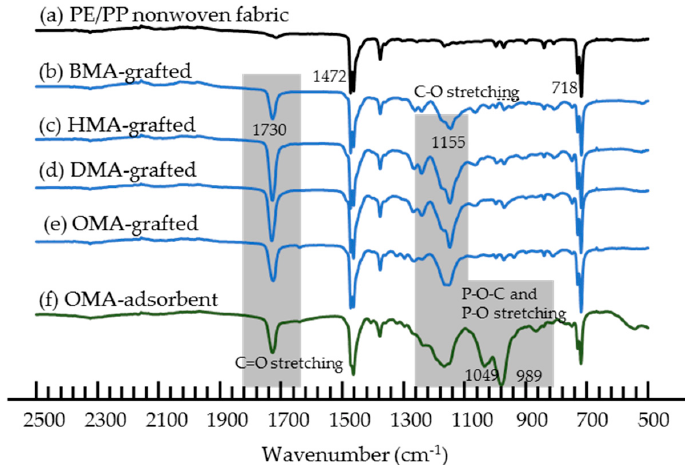
Figure 2. FTIR spectra of ( a ) PE / PP nonwoven fabric, ( b ) BMA-grafted PE / PP nonwoven fabric, ( c ) HMA-grafted PE / PP nonwoven fabric, ( d ) DMA-grafted PE / PP nonwoven fabric, ( e ) OMA-grafted PE / PP nonwoven fabric, and ( f ) OMA-adsorbent prepared by loading of EHEP onto the OMA-grafted PE / PP nonwoven fabric.